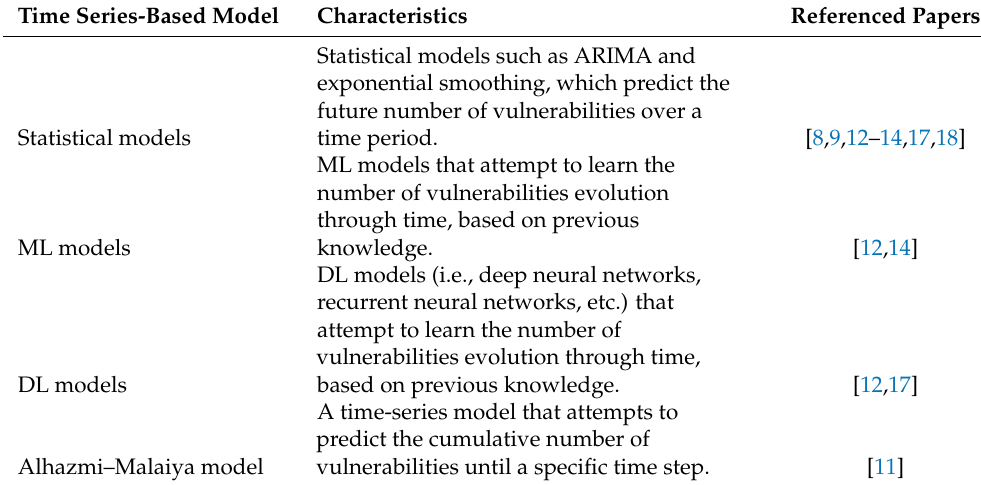
Table 2. Time series-based models’ discrete characteristics.